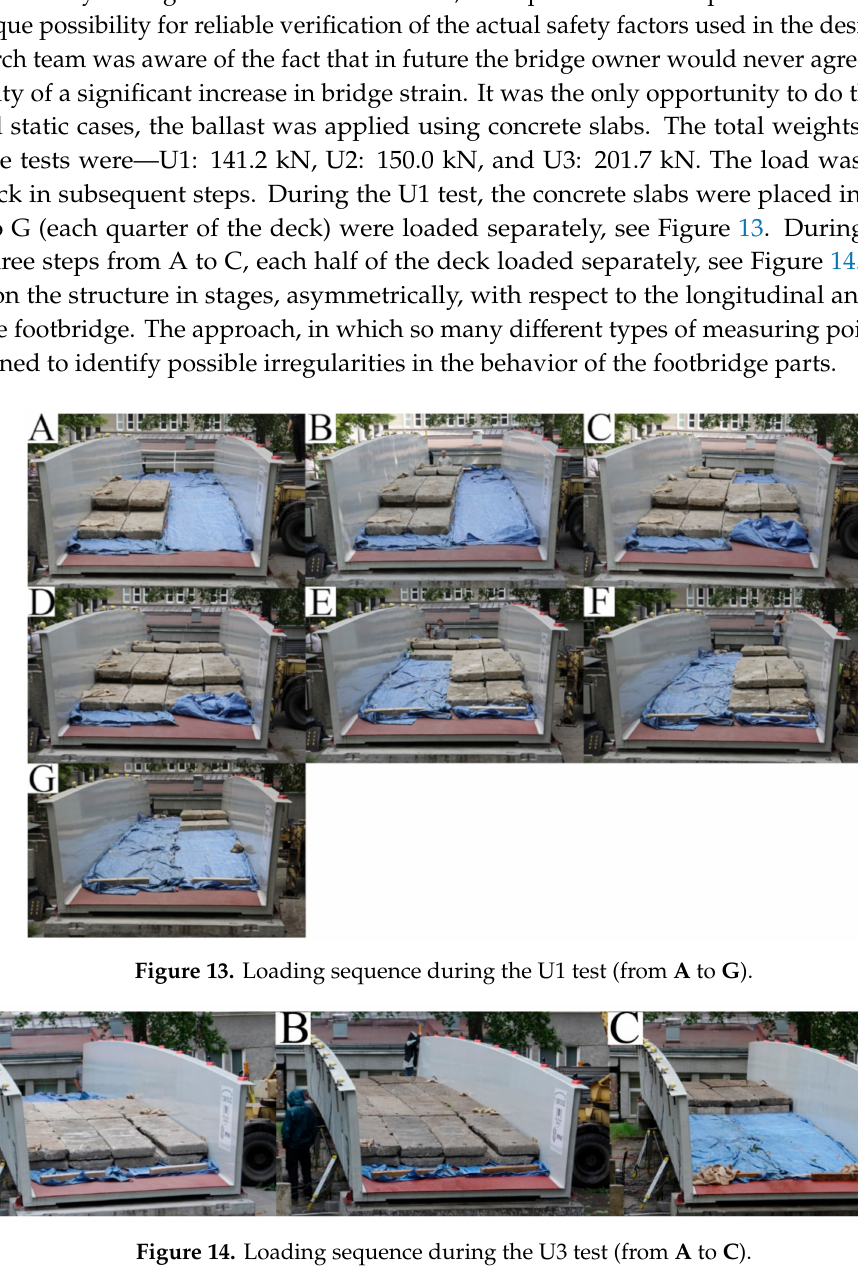
Figure 14. Loading sequence during the U3 test (from A to C